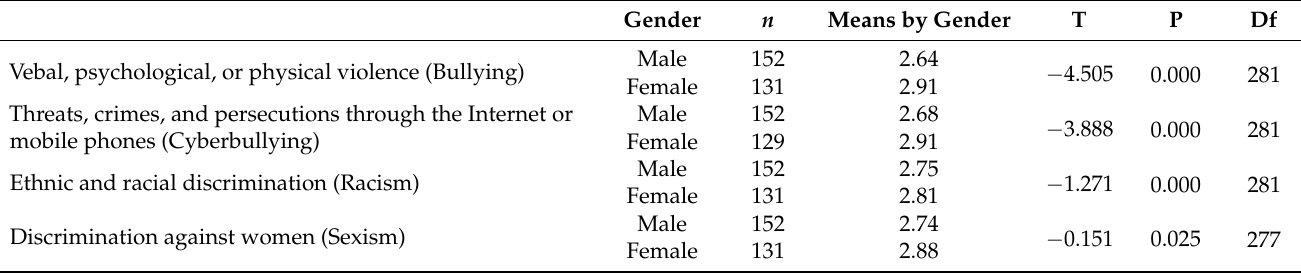
Table 8. Student’s T coefficient between variables: “gender” and “what is your opinion about these problems?”. Gender n Means by Gender T P